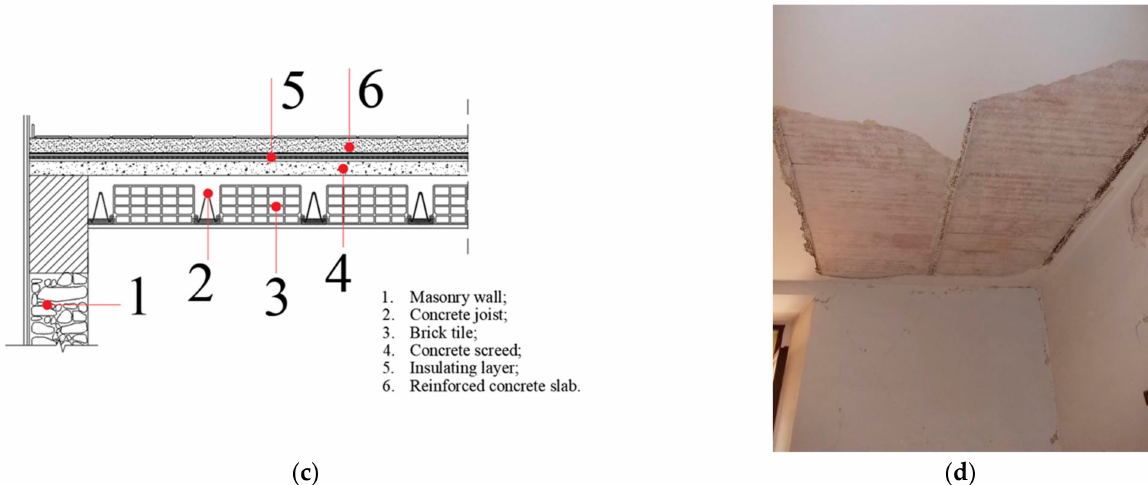
Figure 15. Floor typologies: ( a ) Structural cross sections of the timber floor; ( b ) Structural cross sections of the steel joists and brick tiles floor; ( c ) Structural cross sections of the RC floor; ( d ) Photo of the investigated floor.